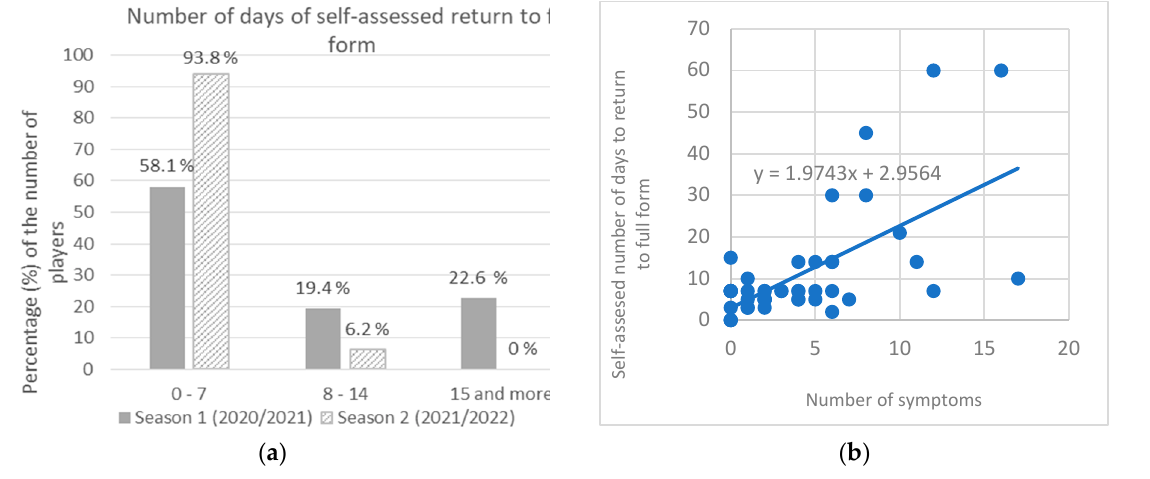
Figure 4. ( a ) Self-assessed number of days to return to full form; ( b ) correlation of number of symptoms and self-assessed number of days to return to full